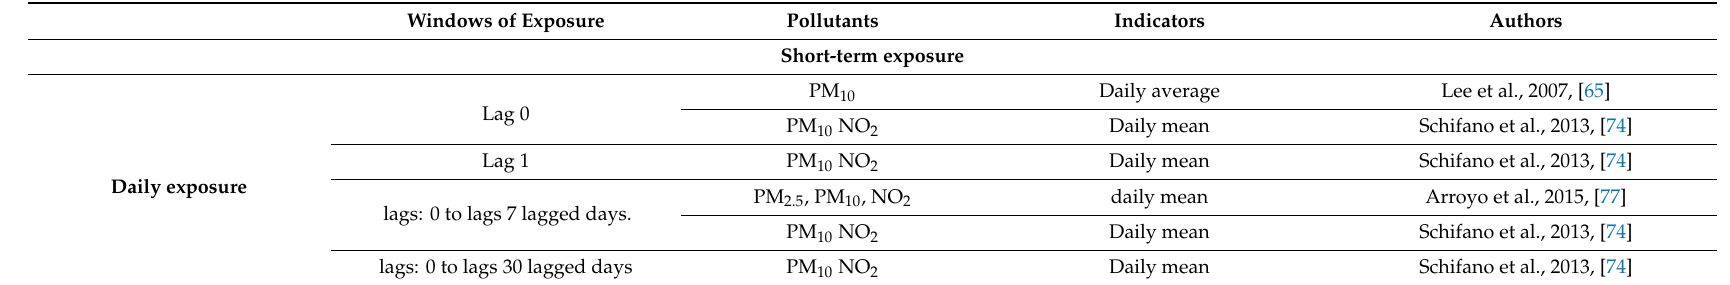
Table 4. Definition and assessment of window of